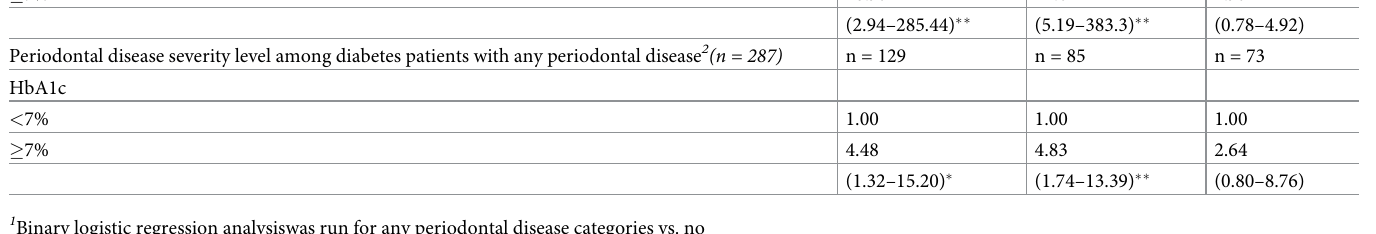
Table 4. Association between periodontal disease and poor diabetes control stratified by oral hygiene behaviours. Indicators and